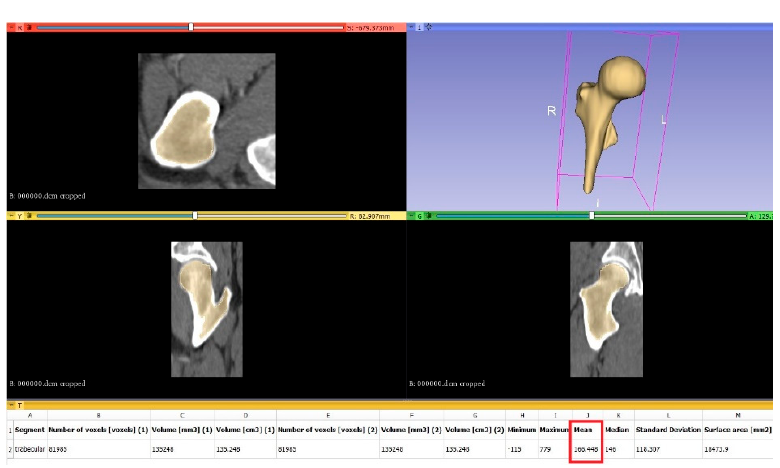
Figure 3. Trabecular bone segment statistics.